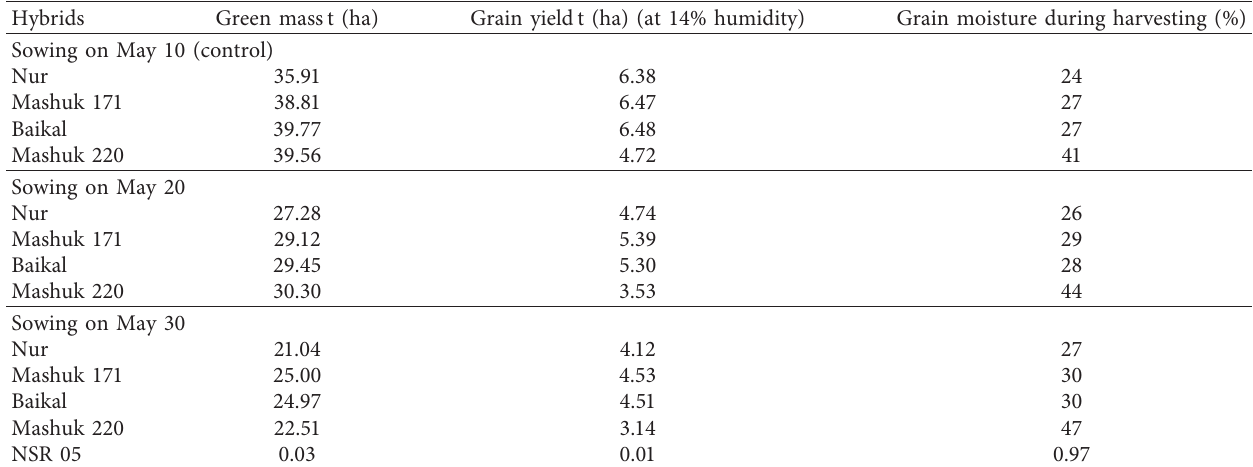
Table 1: The yield of maize hybrids at different sowing time.